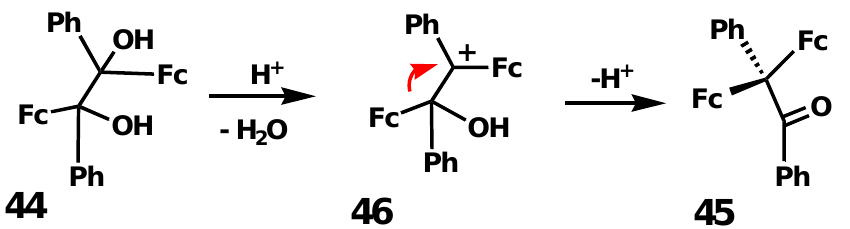
Scheme 12. Pinacol rearrangement showing favored migration of ferrocenyl over phenyl.